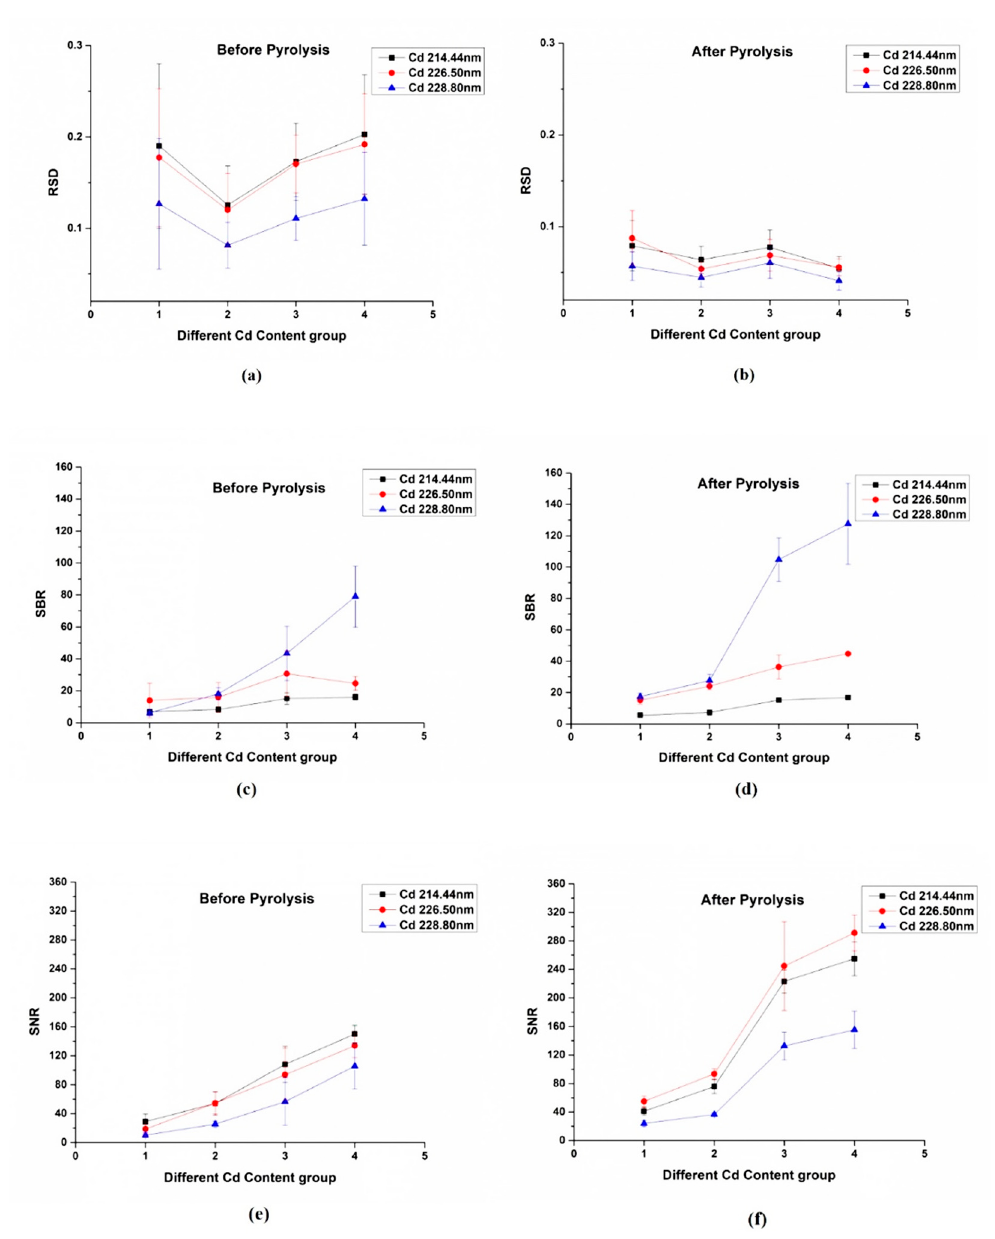
Figure 3. LIBS spectra. The relative standard deviation (RSD) of three Cd emission lines before pyrolysis ( a ) and after pyrolysis ( b ); the signal-to-background ratio (SBR) of three Cd emission lines before pyrolysis ( c ) and after pyrolysis ( d ); the signal-to-noise ratio (SNR) of three Cd emission lines before pyrolysis ( e ) and after pyrolysis ( f ). There are five samples in each group.